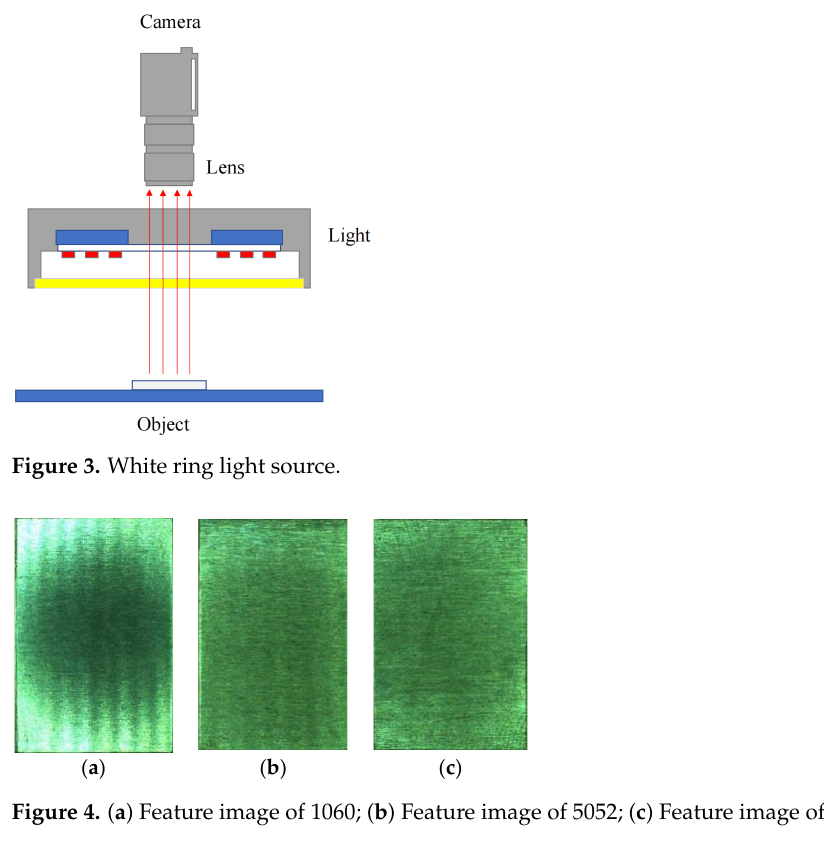
Figure 4. ( a ) Feature image of 1060; ( b ) Feature image of 5052; ( c ) Feature image of 6061.